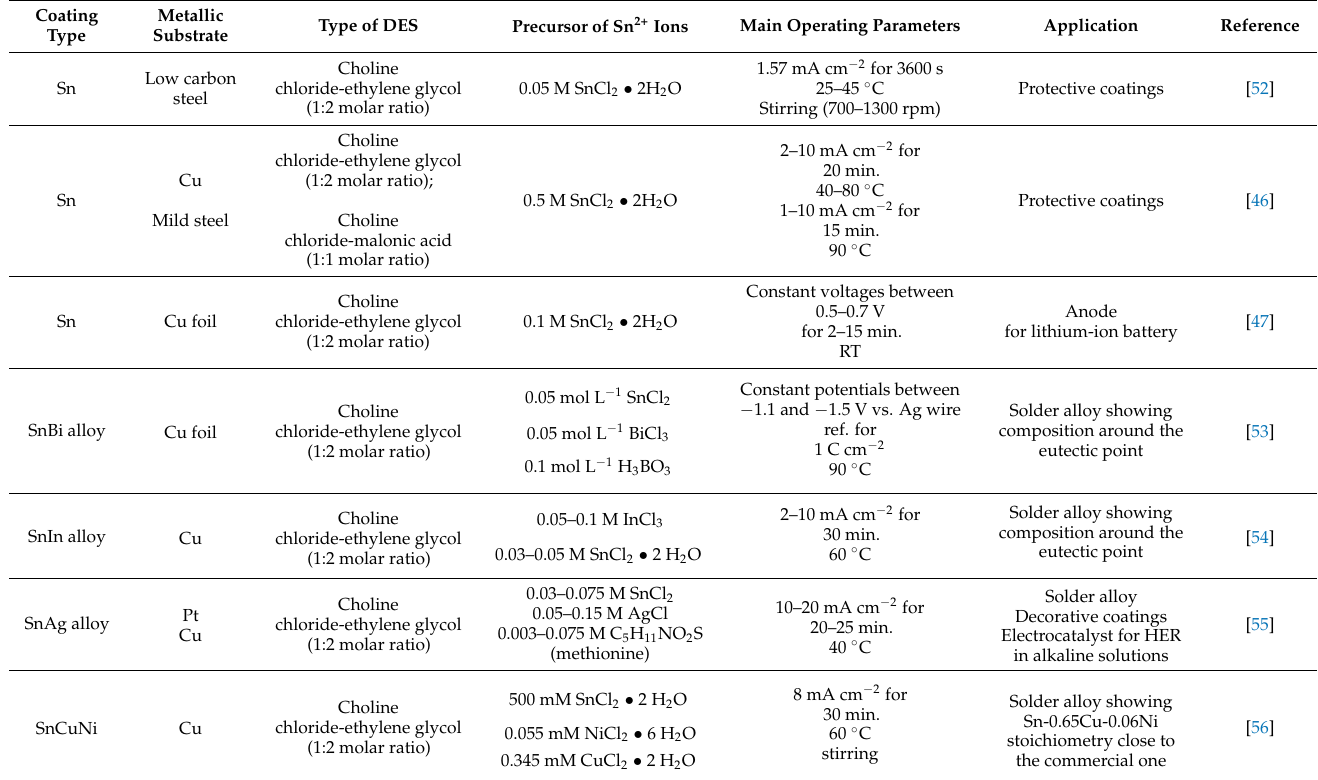
Table 2. Results from the literature data regarding the electrodeposition of Sn and Sn alloys from DES based